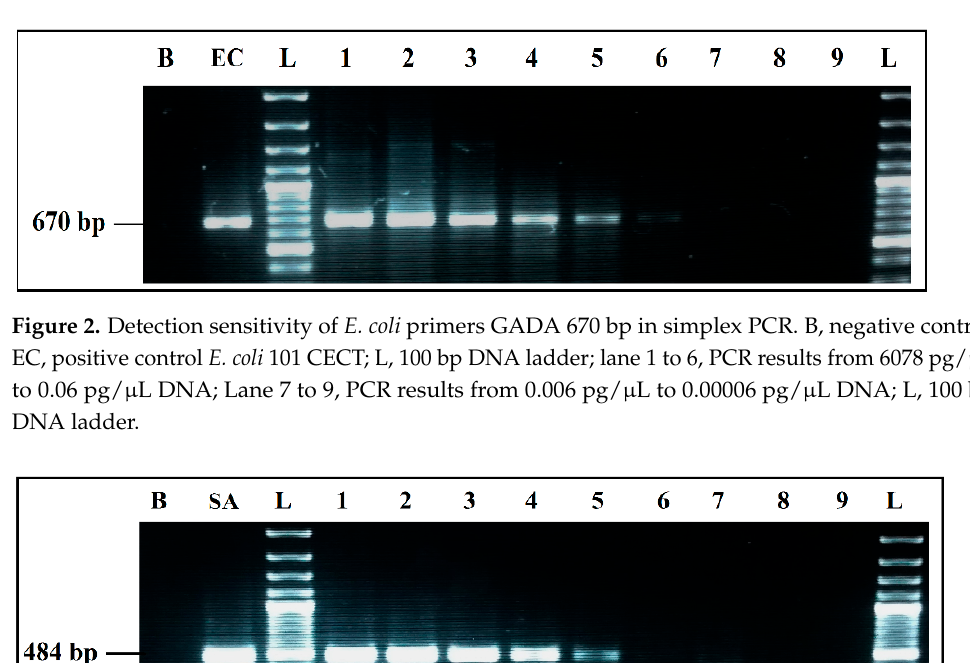
Figure 5. Detection sensitivity of S. enterica primers SalinA 284 bp, in Simplex PCR. B, negative con ‐ trol; SE, positive control S. enterica 4266 CECT ; L, 100 bp DNA ladder; lane 1 to 9, PCR results from 4547 pg/ μ L to 0.00005 pg/ μ L DNA; L, 100 bp DNA ladder. PCR detection limits, when the four primer pairs and their target DNAs were mixed in a single reaction, was evaluated by several PCR mixes containing the same components, whose DNA concentrations differed, following a decreasing gradient, with equal ratios between the four target microorganisms in the same reaction. DNA quantities used were calculated, following the same procedure previously mentioned. The results showed a very clear detection of the four microorganisms (Figure 6), with intense bands (Lane 1). However, by reducing the DNA amount even more (Lane 2), all of the bands were still present, but intensity was lost, which means that the detection lim ‐ its of the quadruplex PCR are approximately 10 pg/ μ L of each DNA template. Figure 6. Detection sensitivity of mPCR from individual cultures. B, negative control; M, mPCR positive control; L, 100 bp DNA ladder; lane 1, mPCR detection with mix DNA (100–70 pg/ μ L) for each target; lane 2, mPCR detection with mix DNA (10–8 pg/ μ L) for each target; lane 3, mPCR de ‐ tection with mix DNA (5–1 pg/ μ L) for each target; lane 4, mPCR detection with mix DNA (0.6–0.1 pg/ μ L) for each target; L, 100 bp DNA ladder.